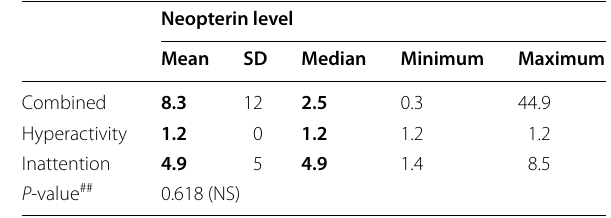
Table 3 Comparison of neopterin level in control group and patient